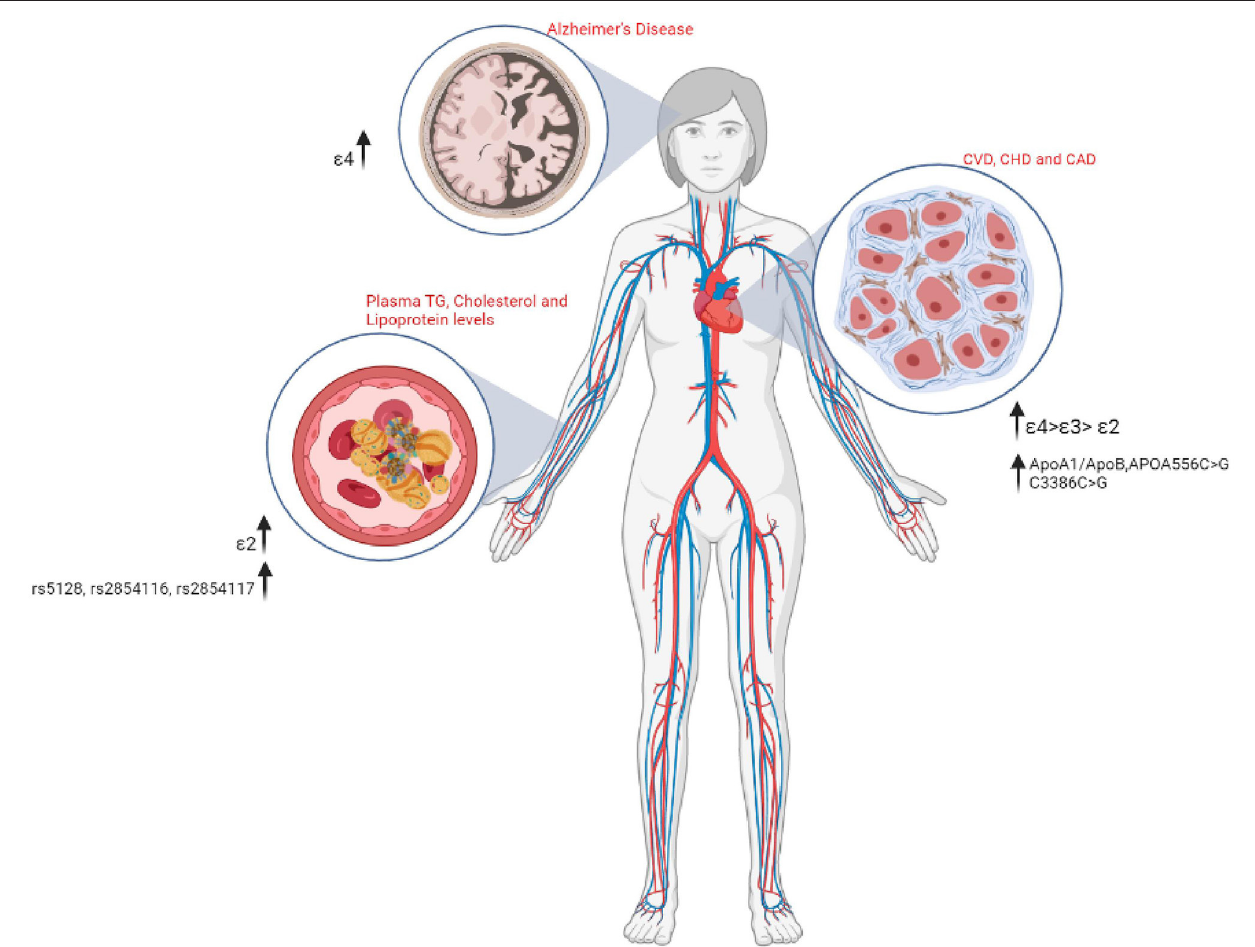
FIGURE 4 | A schematic representation of the various Apolipoprotein polymorphisms and their associated medical